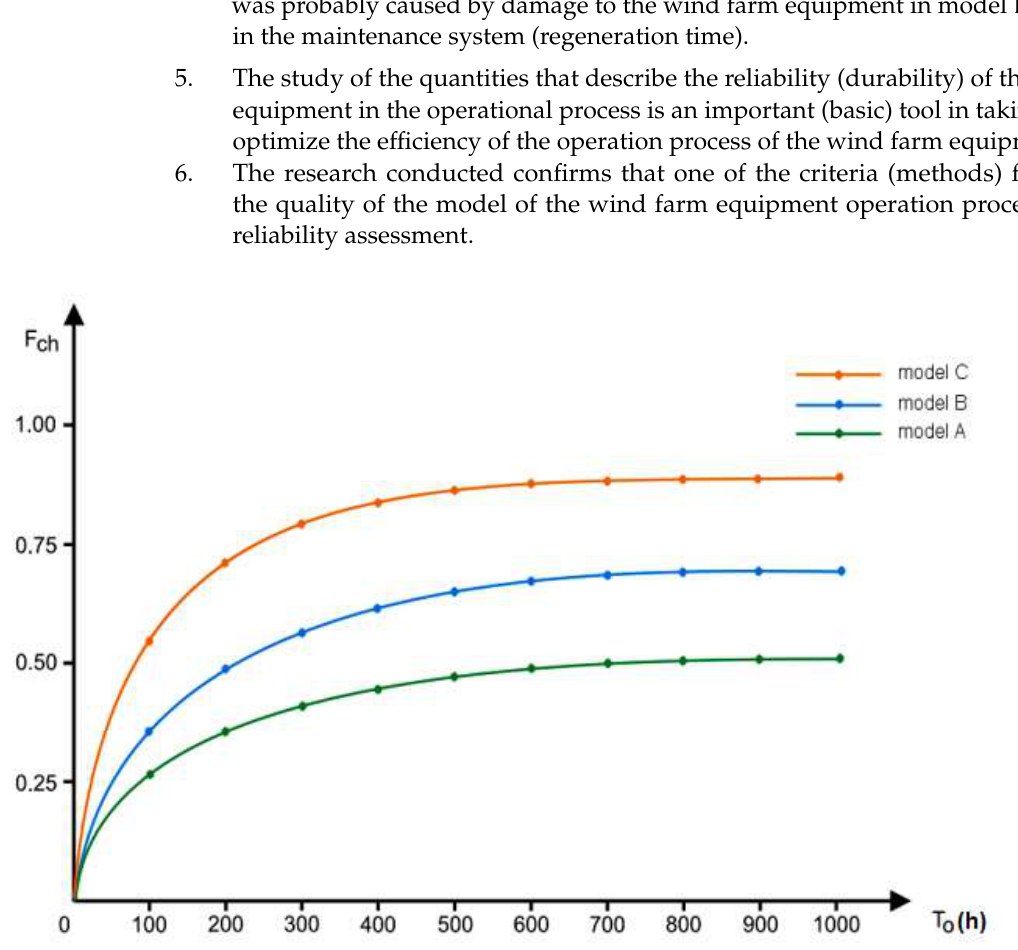
Figure 6. Graph of changes in the facility’s nonavailability coefficient F ch in the facility’s operation process for the operating system models tested (models: A, B and C), where: T o is the time of operation process.